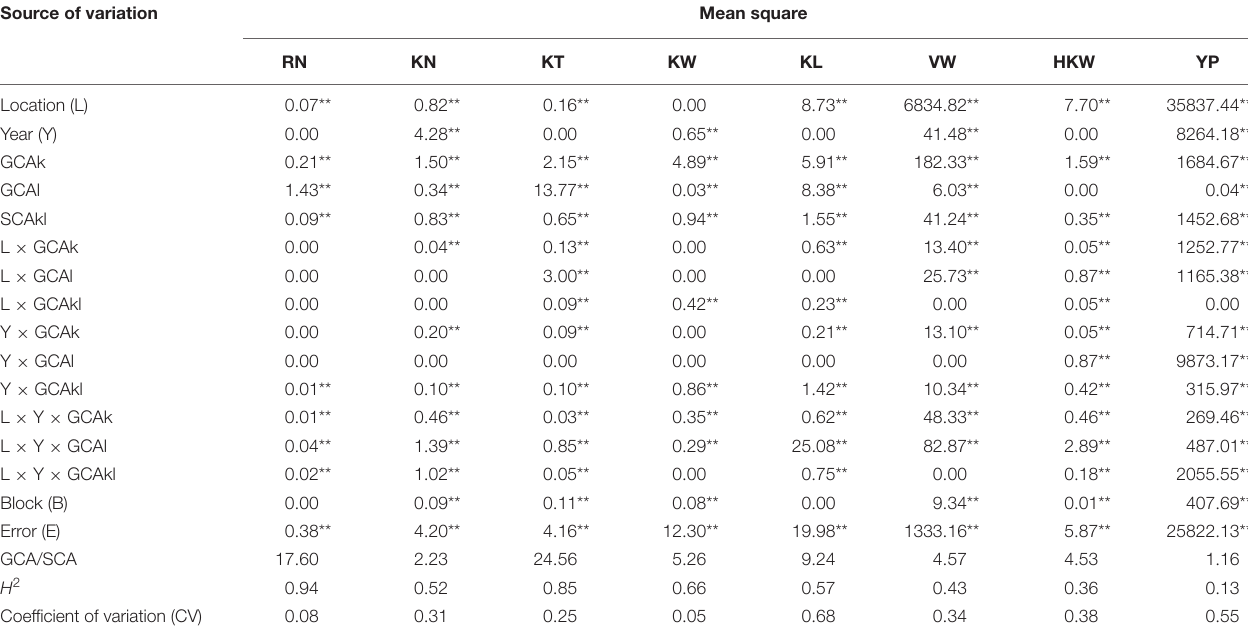
* and ** indicate significance at P < 0.05 and P < 0.01, respectively. RN, Row number; KN, Kernel number per row; KT, Kernel thickness; KW, Kernel width; KL, Kernel length; HKW, 100-kernel weight; VW, Volume weight; YP, Yield per plot. TABLE 3 | Combined analyses of variance for eight yield-related traits in the testcross population. Source of